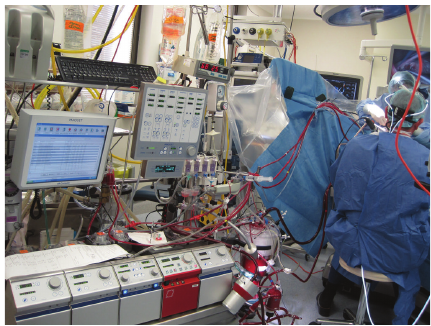
Figure 2: Heart Lung machine with peripheral cannulation via the femoral vessels.